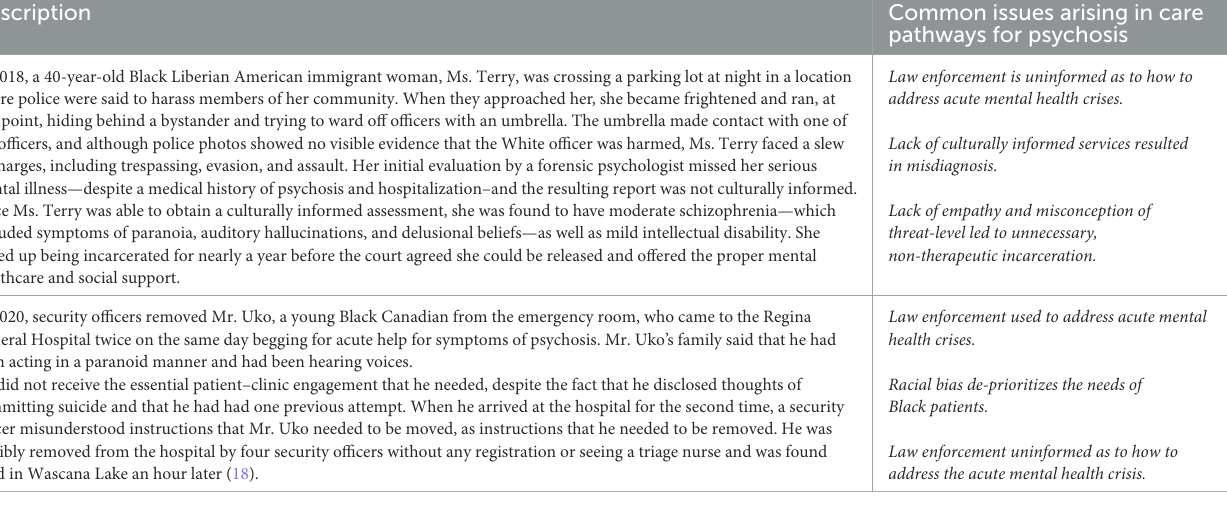
TABLE 2 Case study: The focus on identity rather than care. Description Common issues arising in care